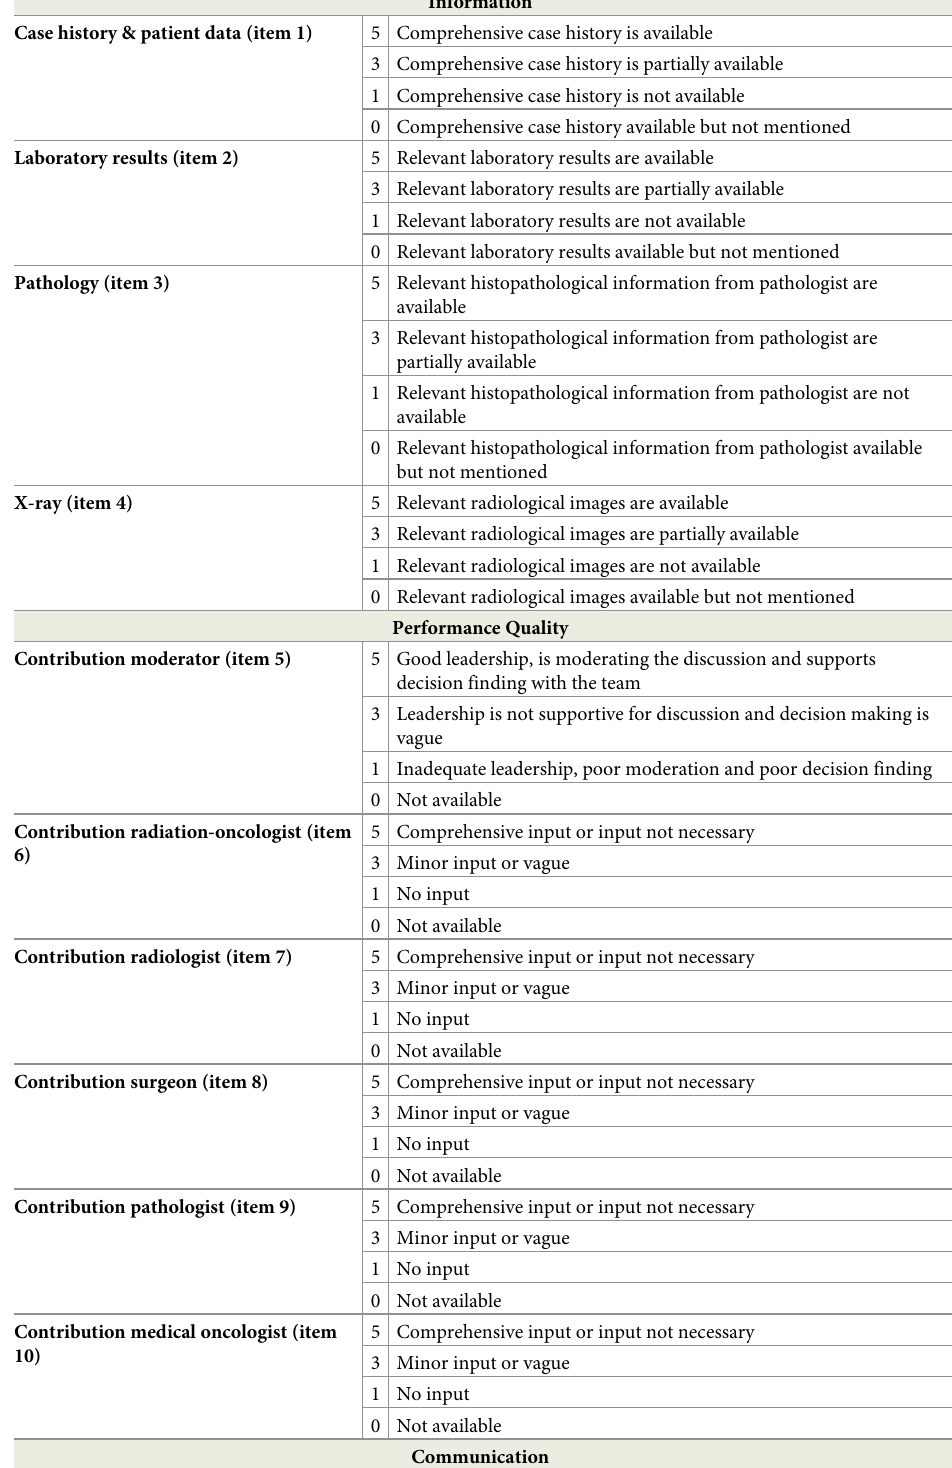
Table 1. MTD/TB team performance assessment